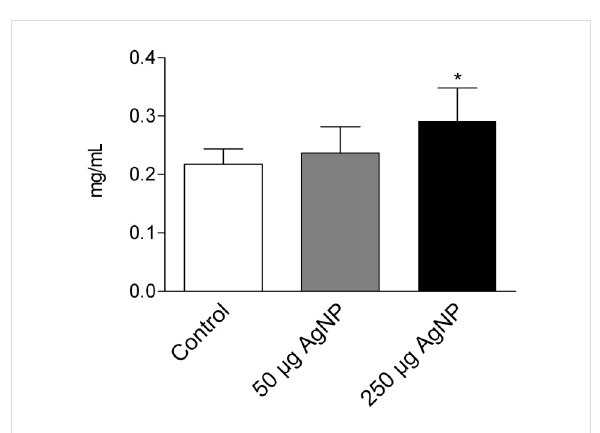
membrane integrity is, therefore, a marker of cytotoxic effects.